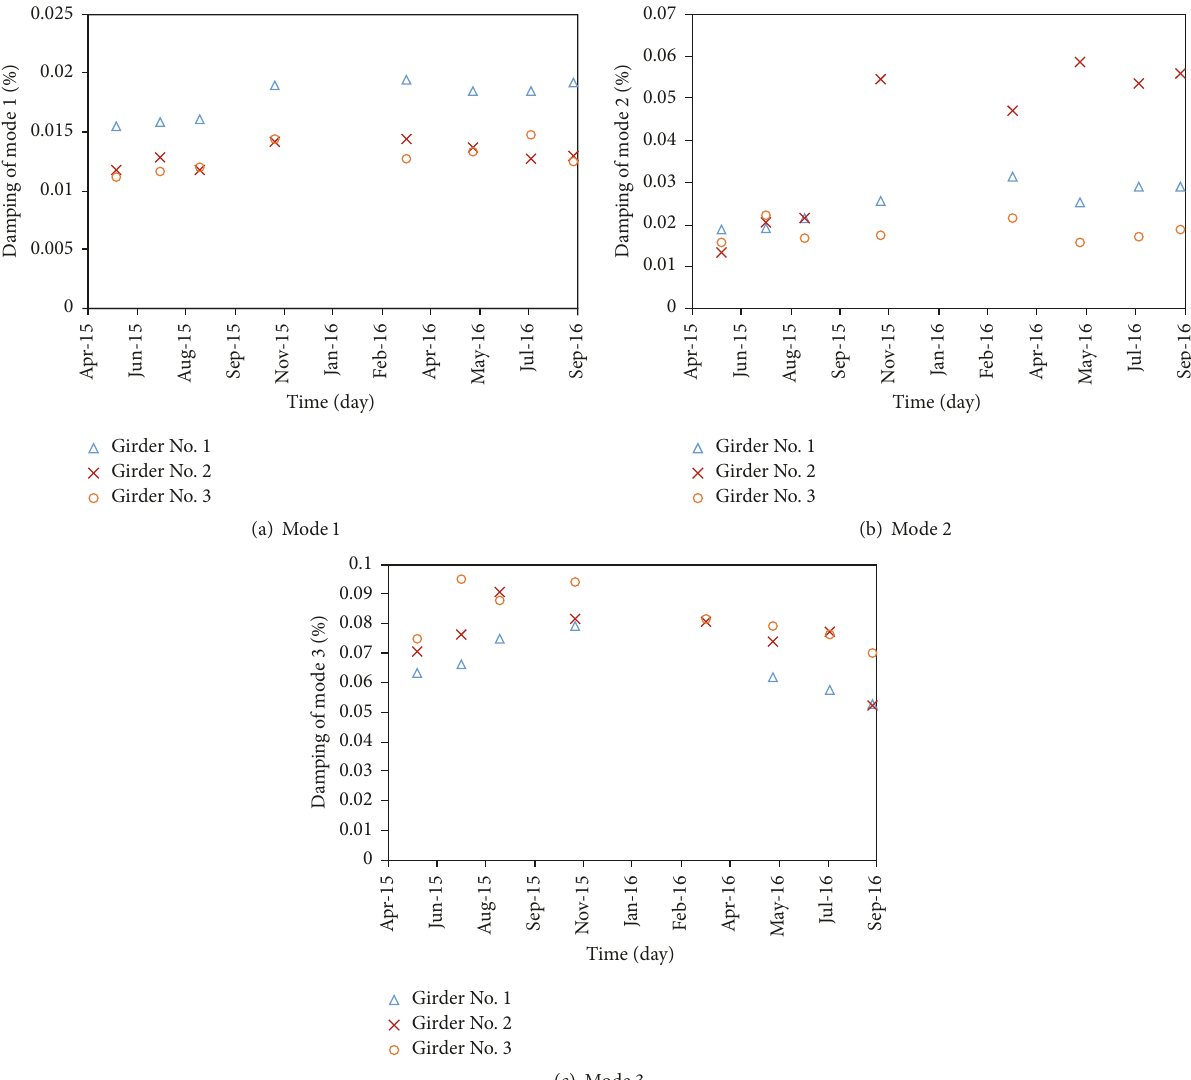
Girder No. 1 Girder No. 2 Girder No.